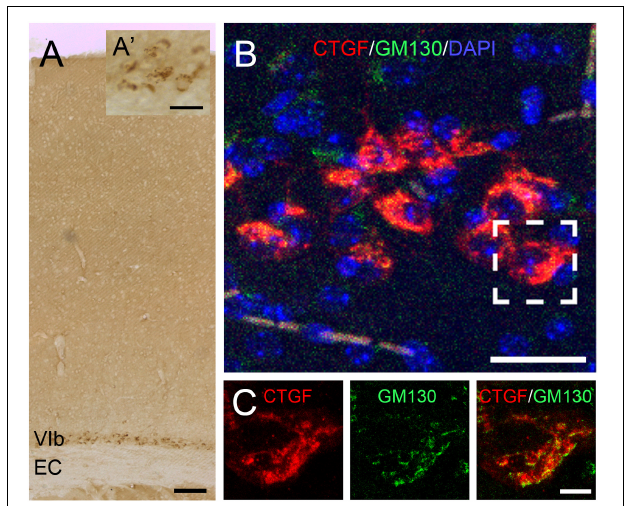
FIGURE 1 | Expression of CTGF in the cerebral cortex. CTGF is expressed in the layer VIb of the cerebral cortex, above the external capsule (EC), in an adult mouse brain (A) . The CTGF-positive immunoreactive signals are located in the cytoplasm surrounding the nucleus (A’) . Intracellular distribution of CTGF is closely associated with the Golgi apparatus (B,C) . CTGF-positive signals (red) are close to signals of GM130, a cis- Golgi matrix protein (green) in the layer VIb neurons. Scale bar is 100 µ m in A, 25 µ m in A’ , 25 µ m in B , and 5 µ m in C